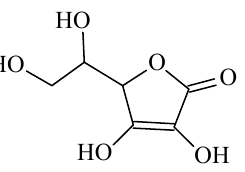
Figure 16. Ascorbic acid chemical structure.